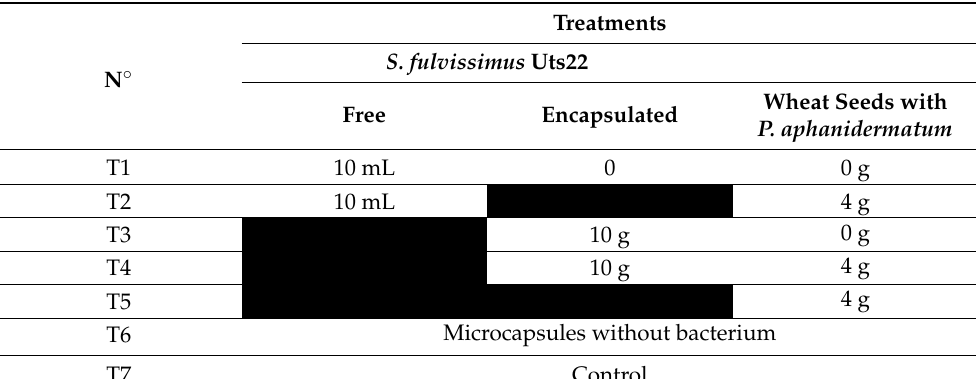
Table 1. Experimental protocol followed for obtaining suspension of S. fulvissimus Uts22 to study their potential on cucumber. Treatments S. fulvissimus Uts22 N ◦ Wheat Seeds Free Encapsulated